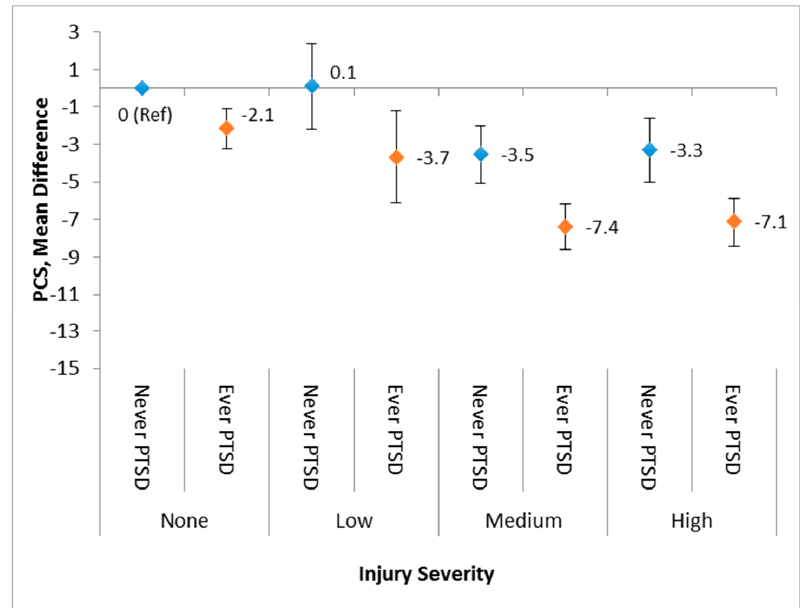
Figure 3. Adjusted regression beta coefficients for PCS-12 predicted by a combination of PTSD and the injury severity level. Int. J. Environ. Res. Public Health 2019 , 16 , x FOR PEER REVIEW